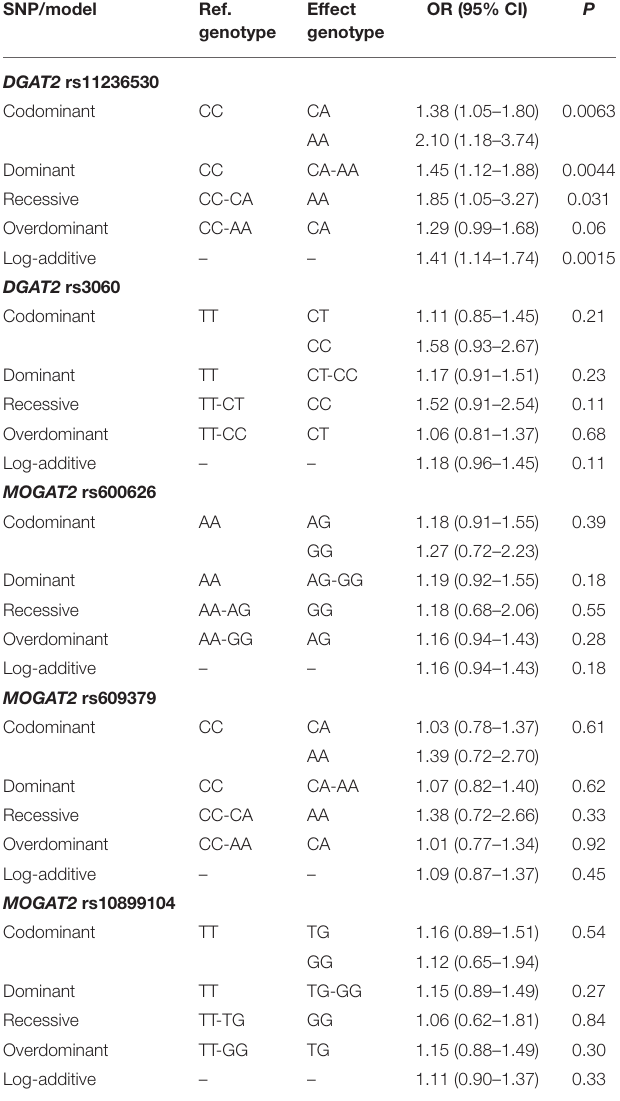
TABLE 3 | DGAT2-MOGAT2 SNPs and the risk of IS.